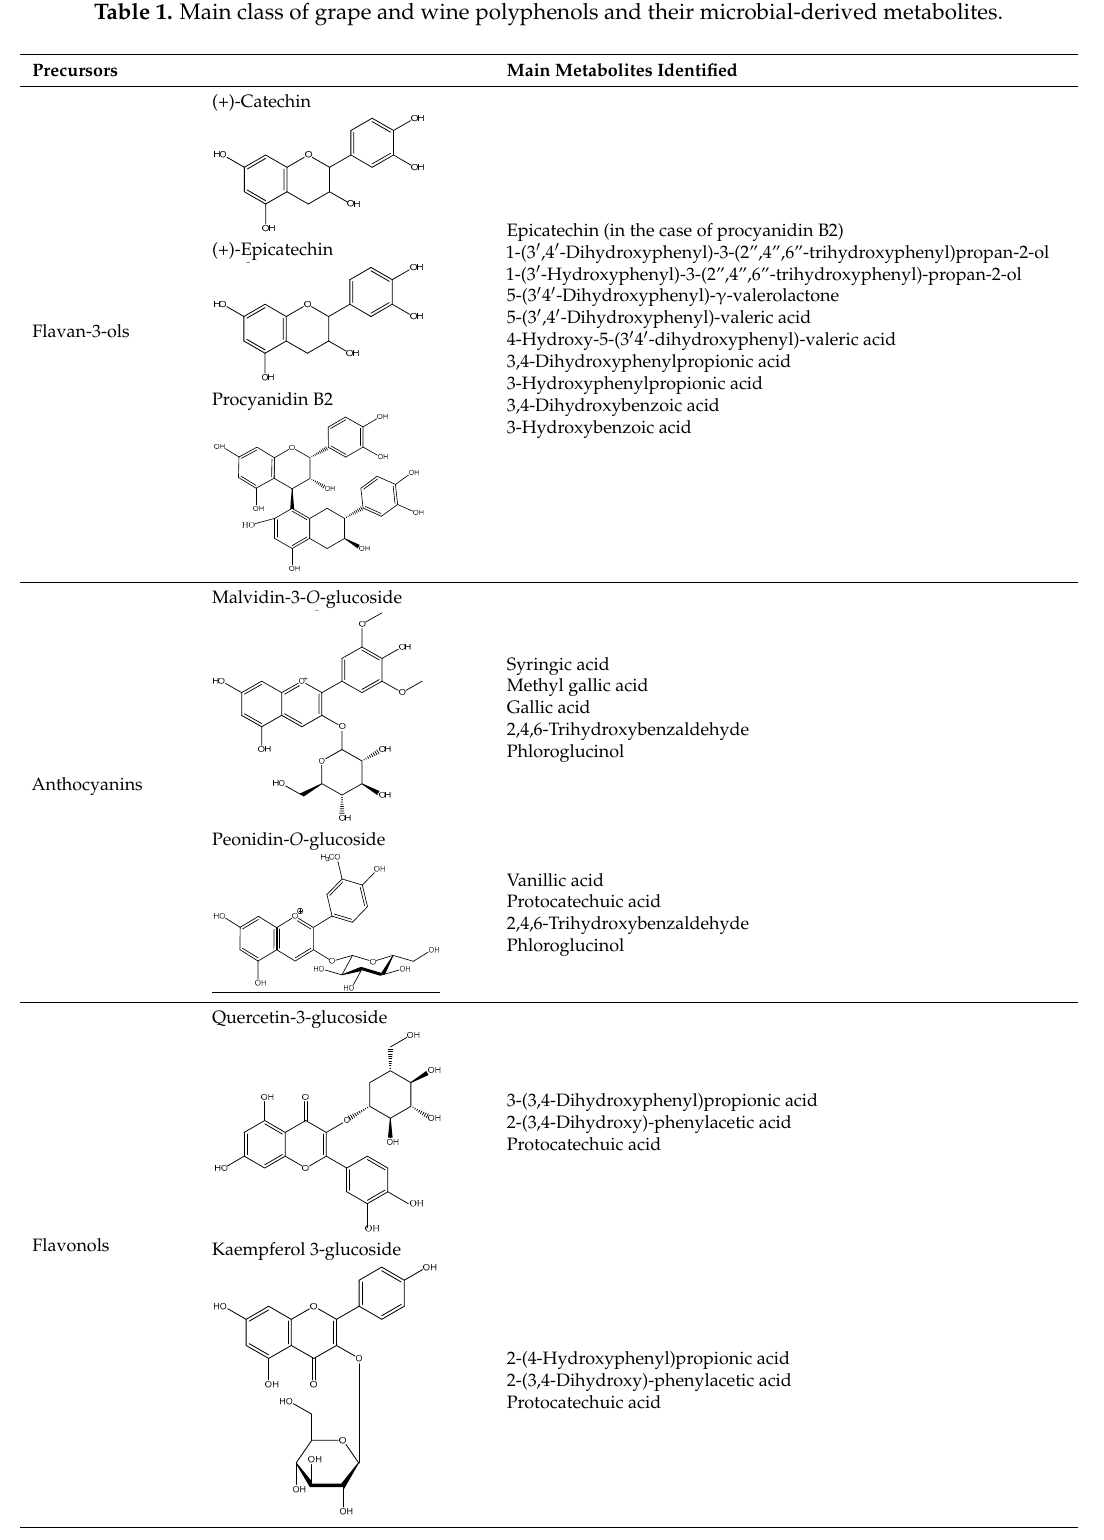
Flavan-3-ols: The catabolism of catechins and oligomeric proanthocyanidins involves the